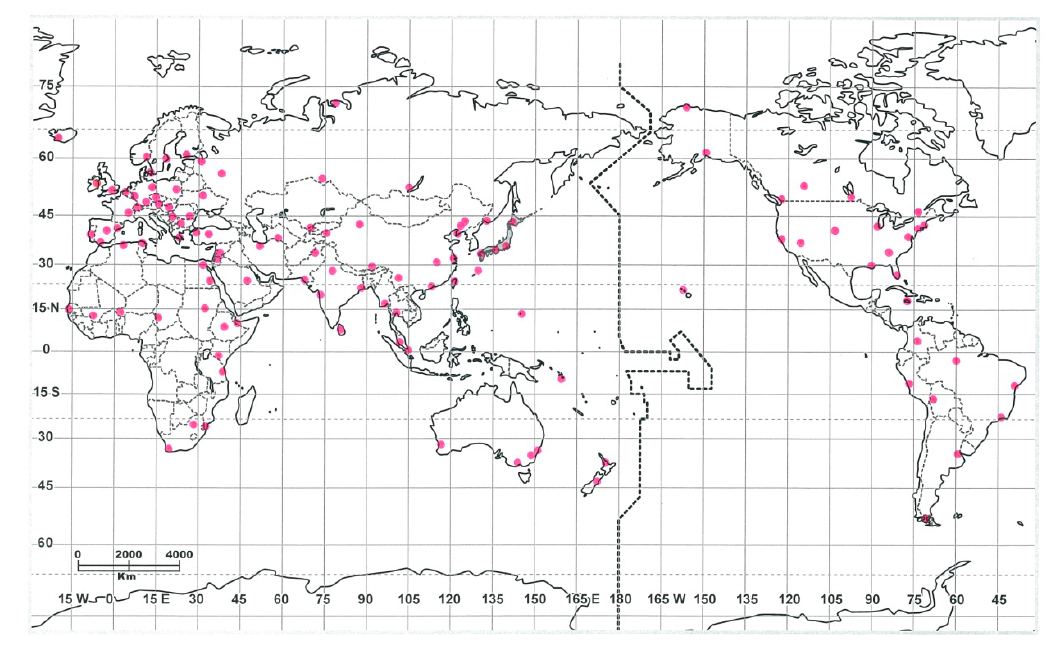
Figure 1. The location of 116 observational stations (pink dots) in the world. Meteorological data on the spots are used in the global analysis.